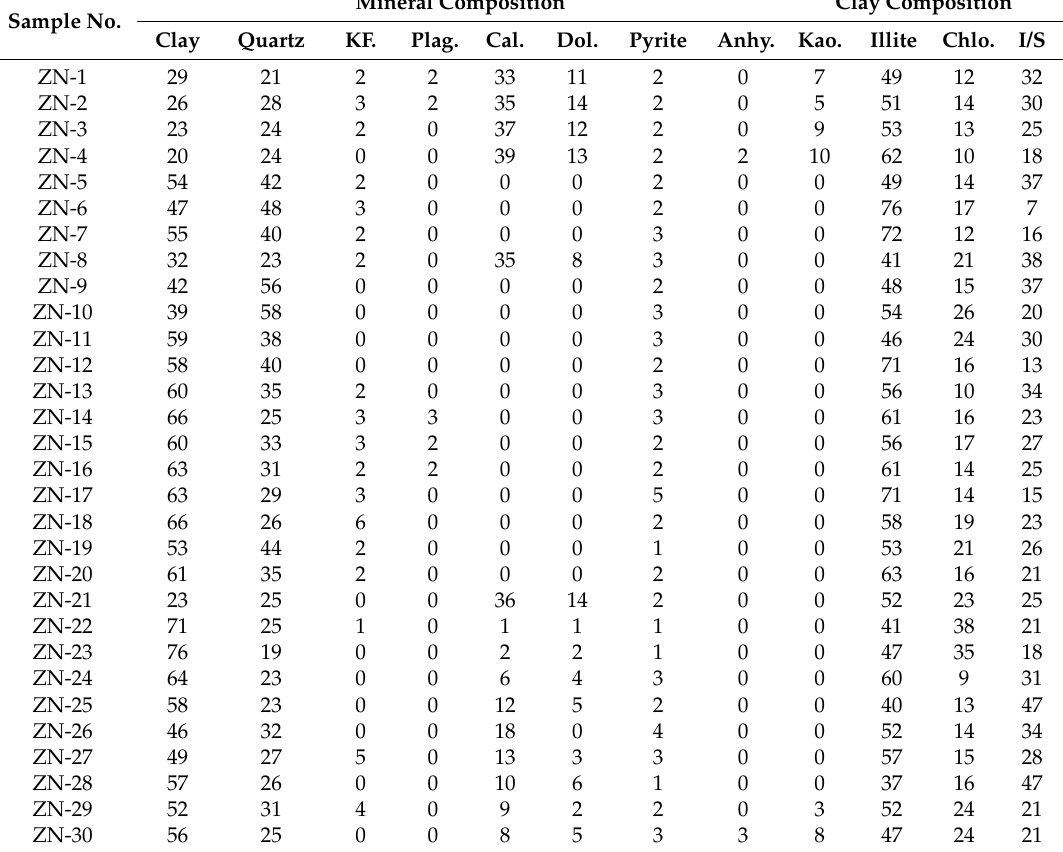
Table 5. The mineralogical compositions of the black rock series samples in this study. (unit: wt%). Mineral Composition Clay Composition Sample No. Clay Quartz KF. Plag. Cal. Dol. Pyrite Anhy. Kao. Illite Chlo. I/S